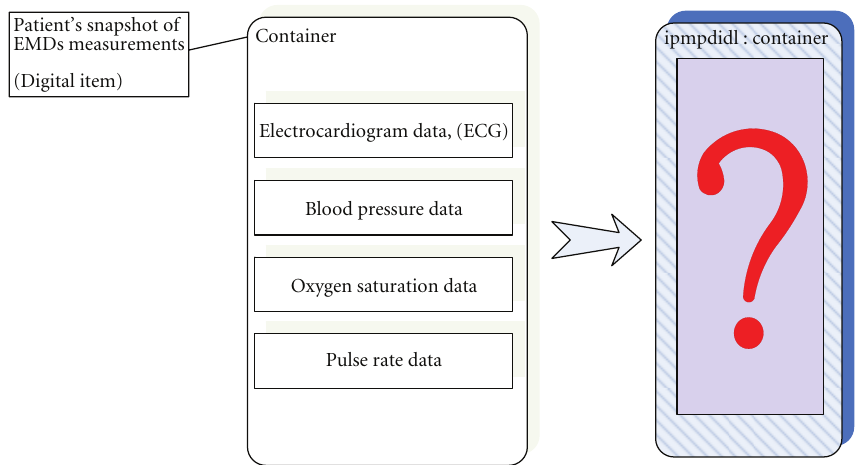
Figure 7: High-level view of encapsulation of a digital item using IPMP framework.